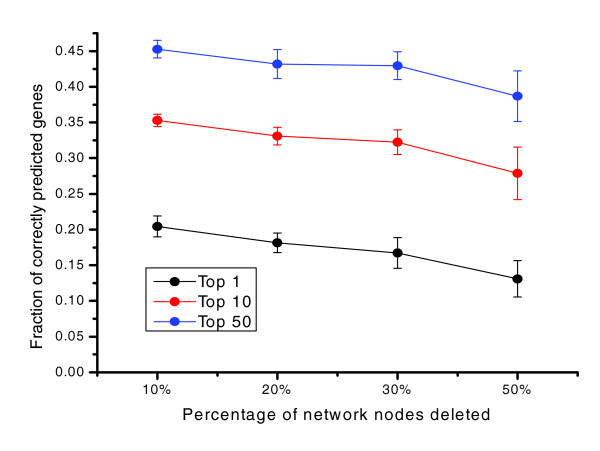
The algorithm performance using an incomplete metabolic network. We show the algorithm performance for yeast networks with a certain fraction of genes randomly deleted. The performance decrease is gradual as up to 50% of the network nodes are deleted. For example, when half of the network is deleted, we can still predict more than 33% of the correct metabolic genes within the top 50 among all candidate genes, compared to 0.8% by random chance.